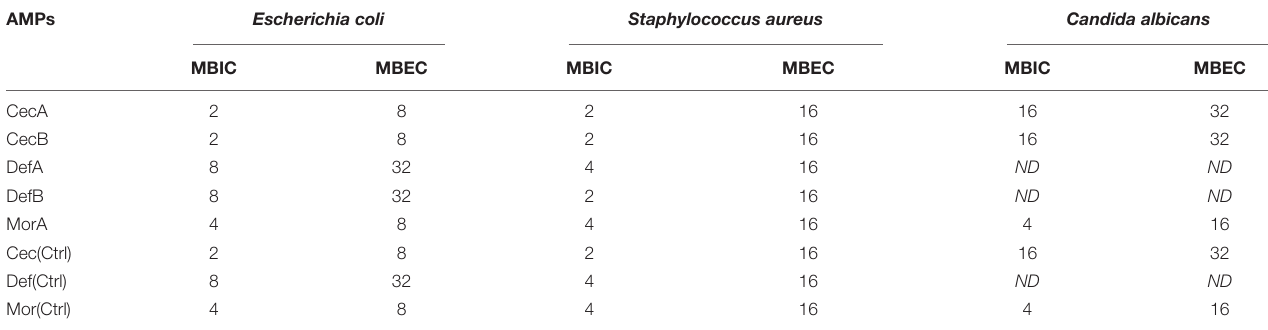
TABLE 4 | Antibiofilm activities of the designed peptides.